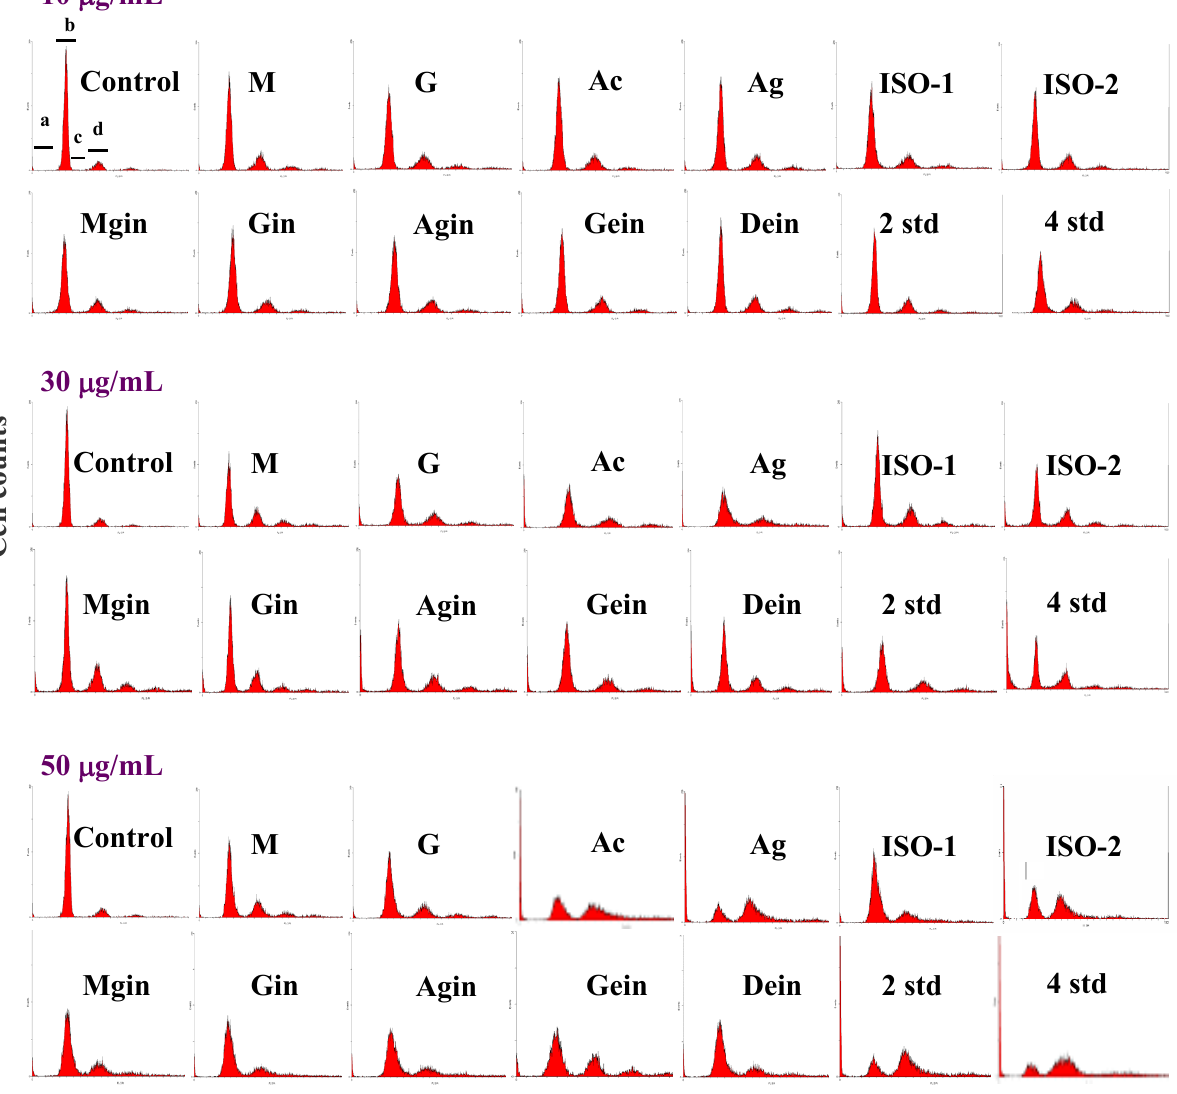
Figure 2. Flow cytometric analysis of Hep G2 cells treated with isoflavone fractions and extracts as well as standards.M: malonylglucoside fraction; G: glucoside fraction;